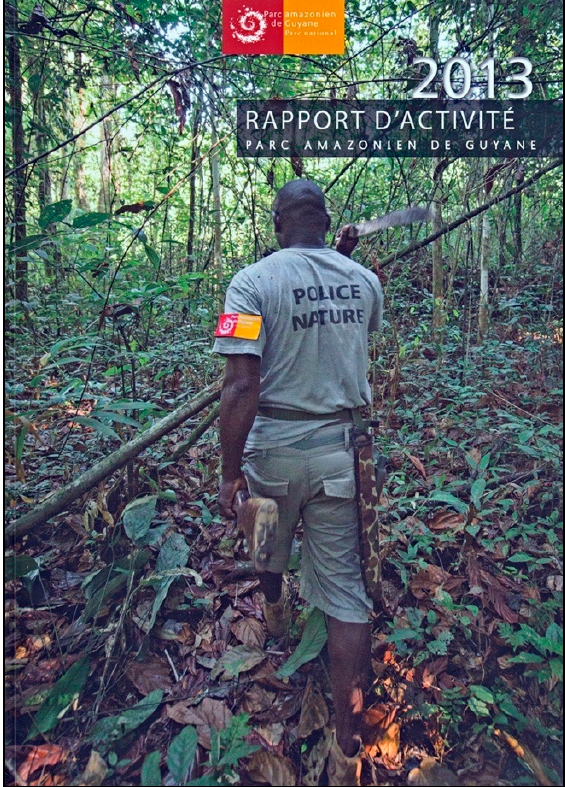
Figure 8. Nature control (Source: Guiana Amazonian Park).